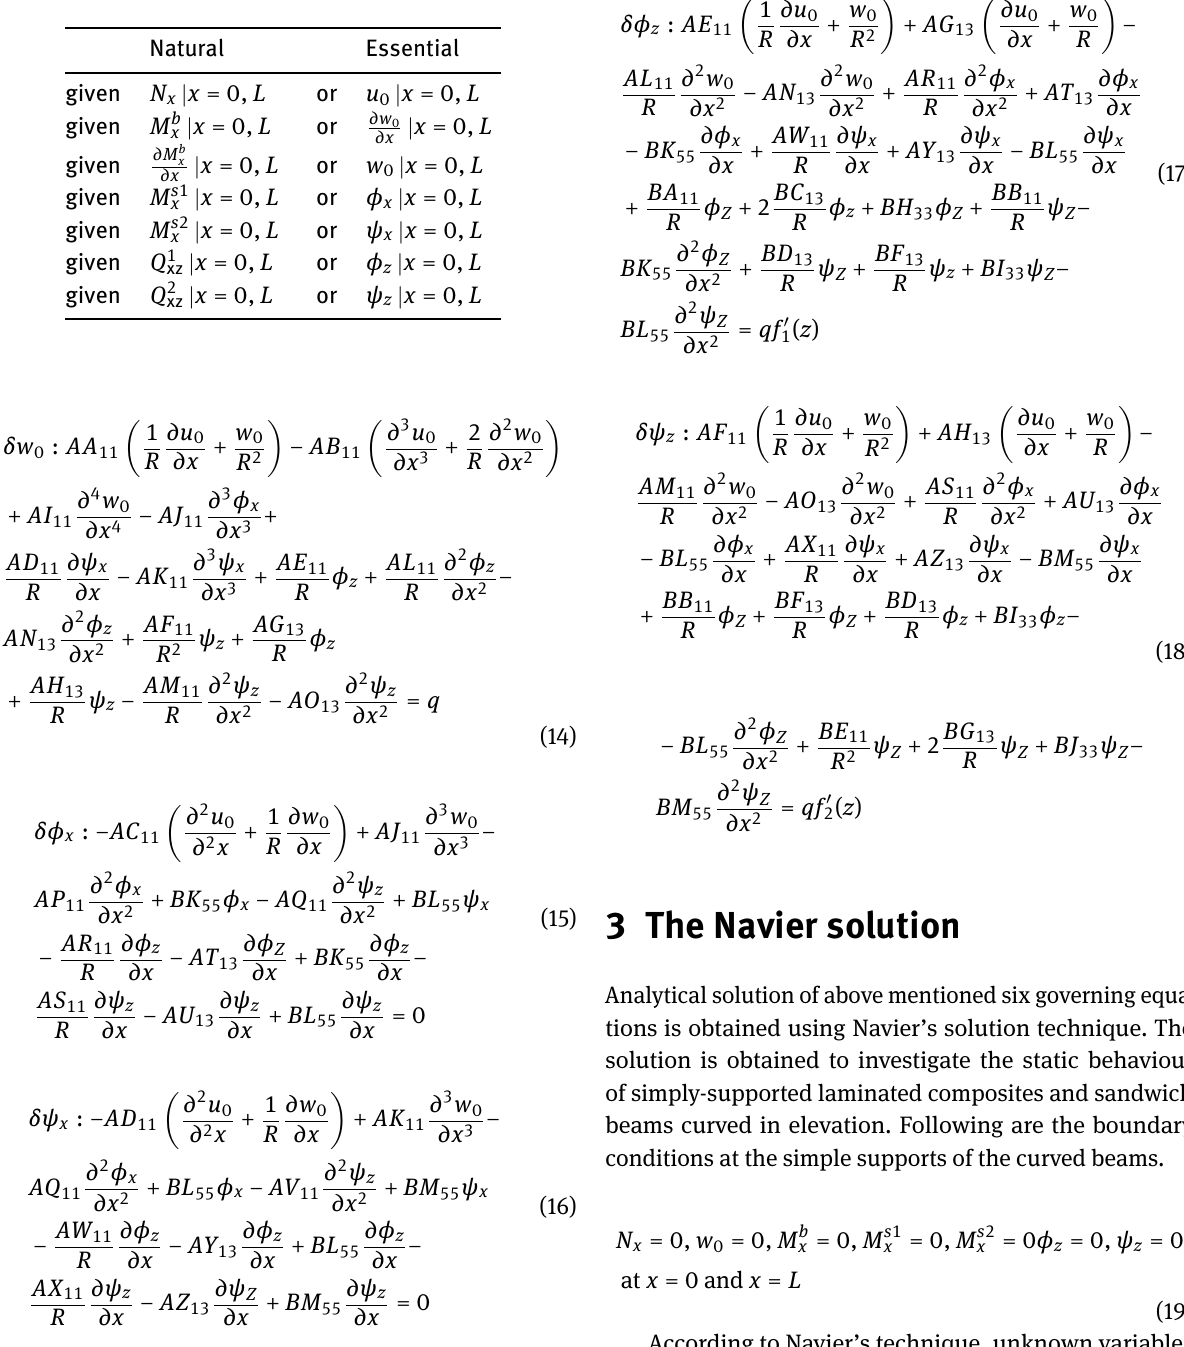
Table 1: Natural and essential boundary conditions associated with the present